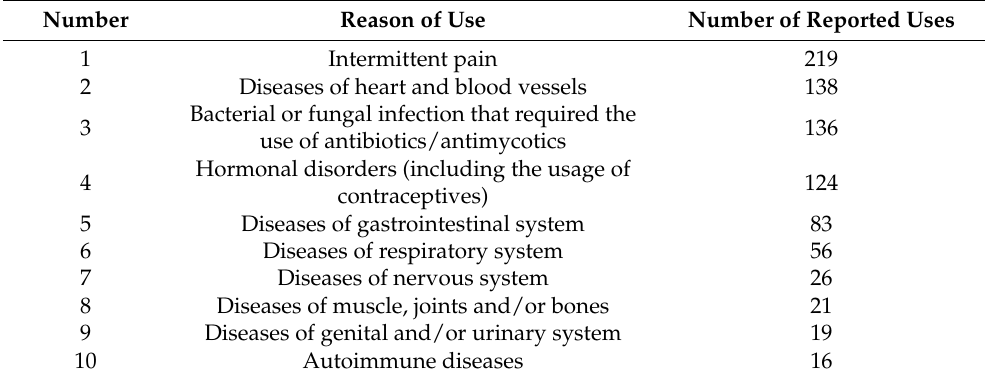
Table 2. The most frequent diseases and/or conditions which required conventional drug therapy.